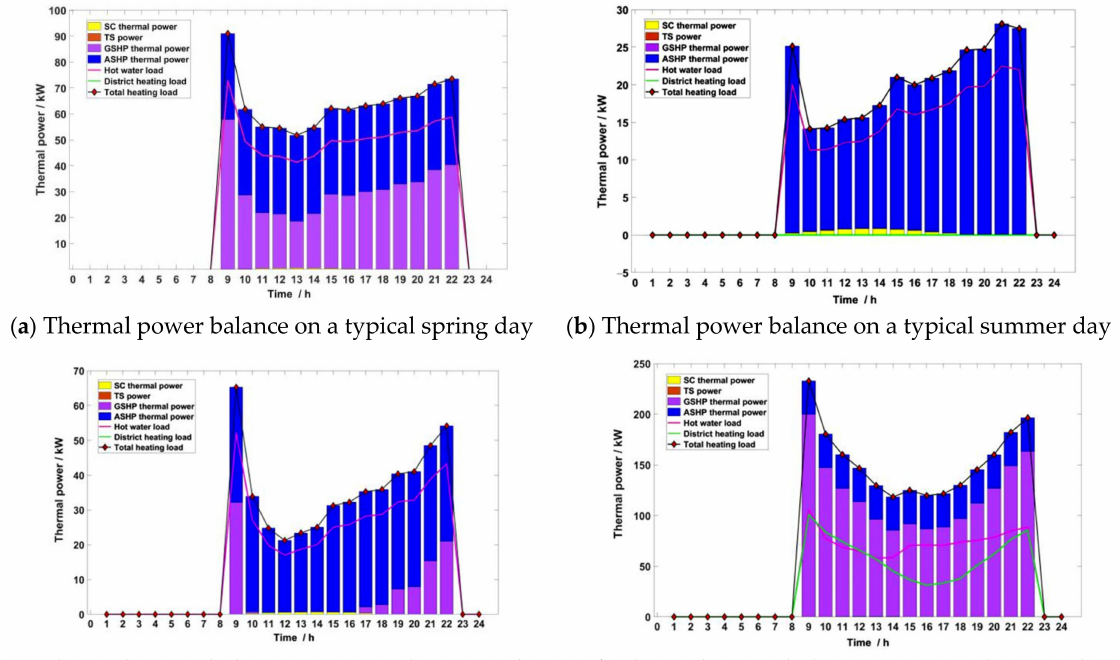
Figure 21. Typical daily thermal power balance in the four